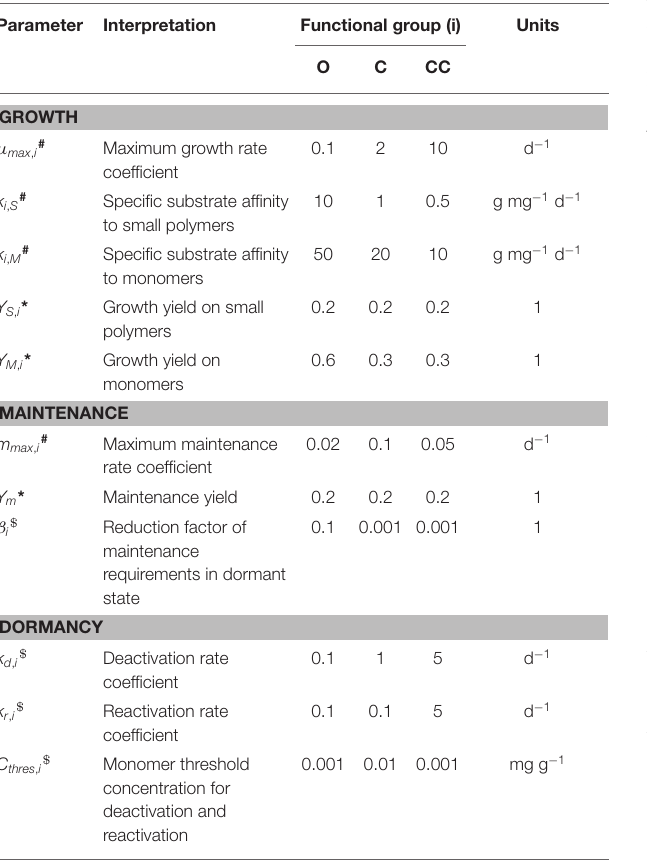
TABLE 1 | Parameterization of functional microbial traits. TABLE 2 | Inhibition, maintenance, and non-microbial parameters and initial values of SpatC model